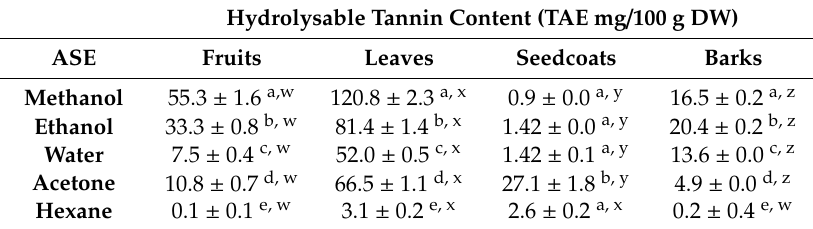
Table 4. Hydrolysable tannins in T. ferdinandiana